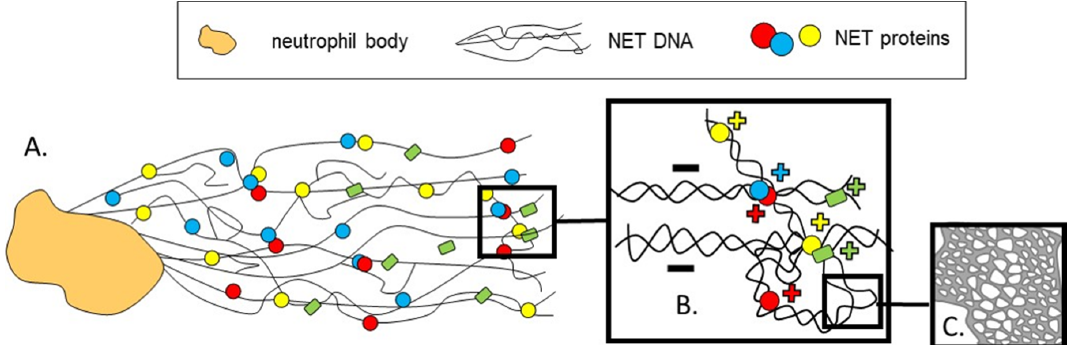
Figure 1. Schematic visualization of neutrophil extracellular traps (NETs) complex architecture at different levels. NETs that are released by neutrophils are composed of extracellular DNA (extDNA) that forms their back ‐ bone, and granular and nuclear proteins. As revealed by atomic force microscopy (AFM) [42]. ( A ) NETs appear as a branching network of DNA filaments decorated with antimicrobial and cytoskeletal proteins and proteases. ( B ) The NET proteins help to hold together and organize the whole structure. An important aspect of the structure is charge as positively charged proteins attach to the negatively charged DNA by electrostatic forces. ( C ) NET structure in nanoscale is porous and the openings are created at junction points where DNA filaments either divide or mingle [42]. +, − indicate the charge of molecules in ( B ).